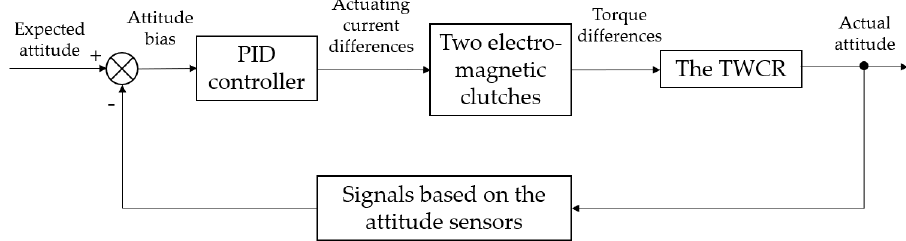
Figure 11. Diagram of the proportional–integral–derivative (PID) controller.